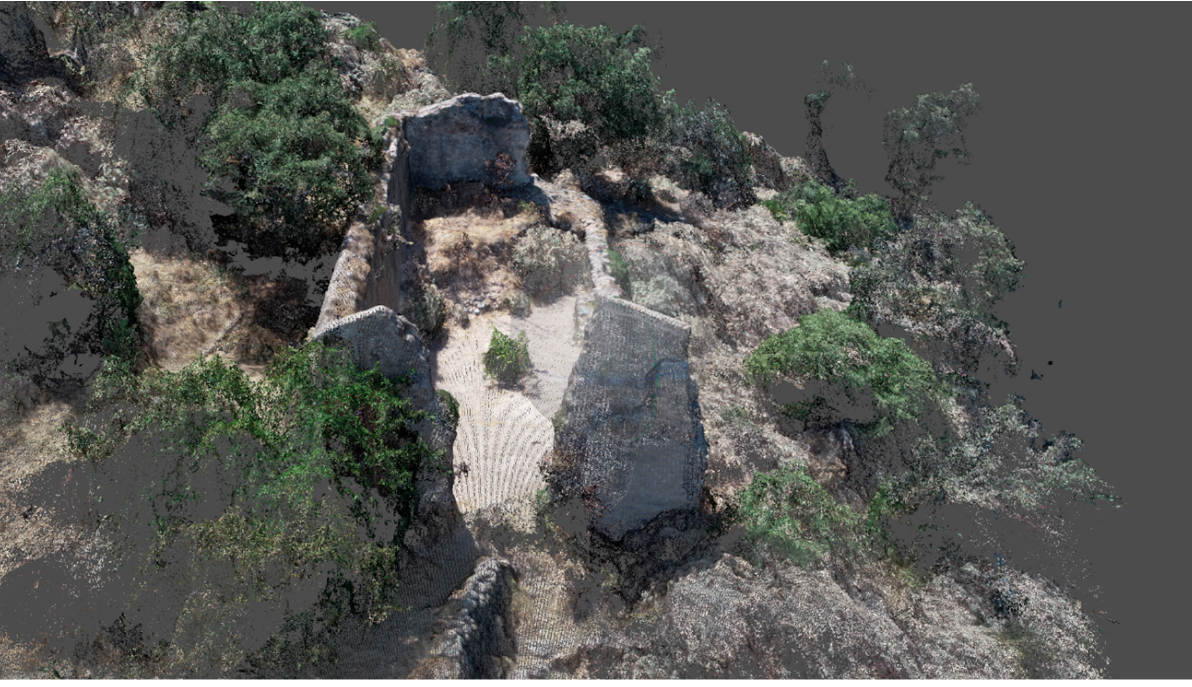
Figure 20. 3D dense cloud of the Church of San Nicola derived from UAV photogrammetry. In this work, a web-based virtual tour system was also generated using the 360 ◦ photographs recorded by the Faro scanner, through Pano2VR software (Figure 21). The VT provides tourists with an opportunity to visit art of the site remotely and to move around freely inside the monuments, interacting with